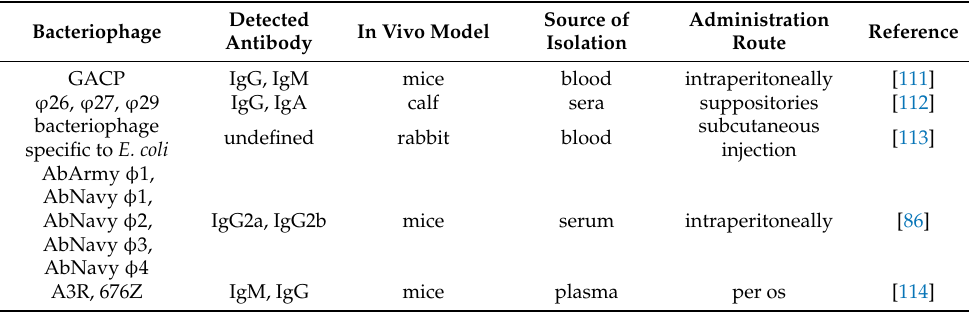
Table 1. Formation of antiphage antibodies after phage administration to